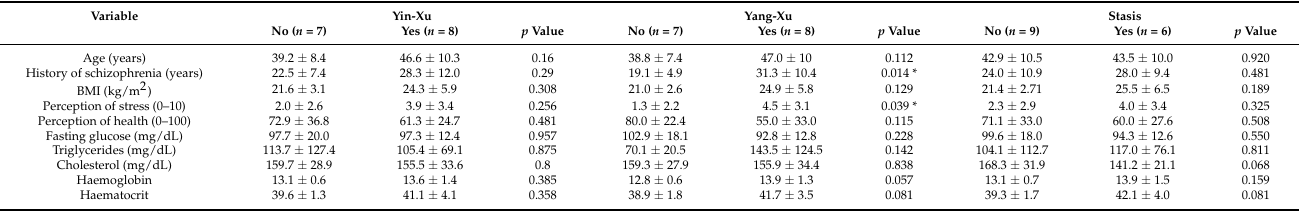
Table 3. Comparisons of participants’ characteristics and biomarkers between constitutions of Yin-Xu, Yang-Xu, and Stasis (treated with clozapine, n =